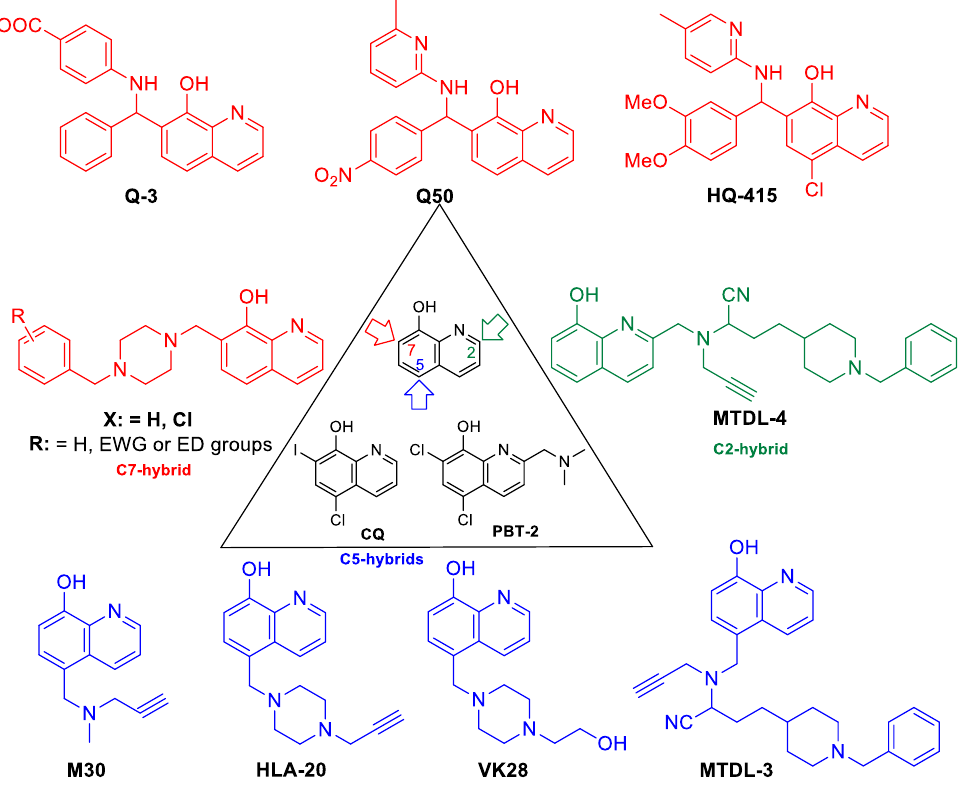
Figure 2. Cytoprotective 8-HQ derivatives.